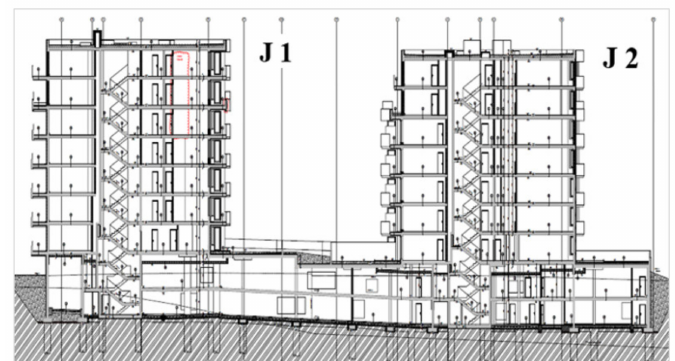
Figure 4. Longitudinal sectional view of building J12 (note: source as Figure 1).